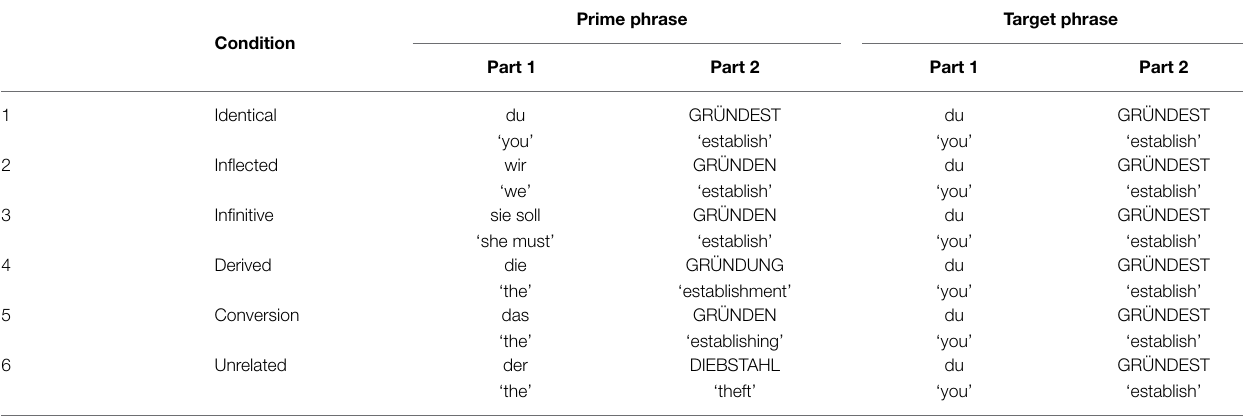
TABLE 5 | Experiment 3: experimental conditions and examples of prime and target phrases.